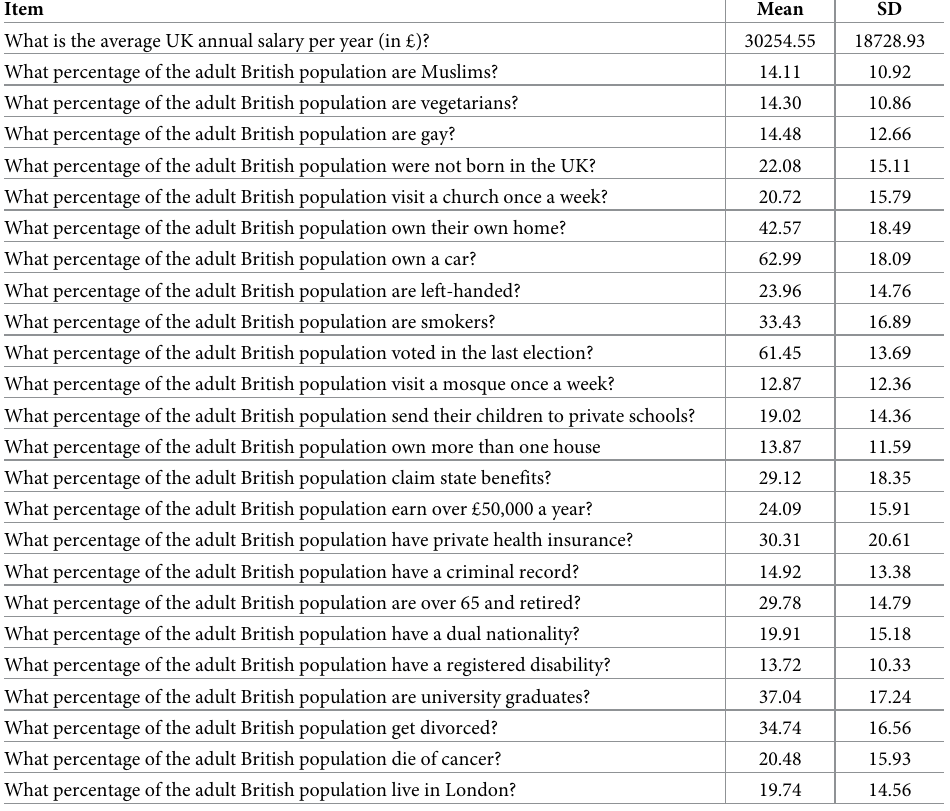
Table 1. Mean estimates for the twenty